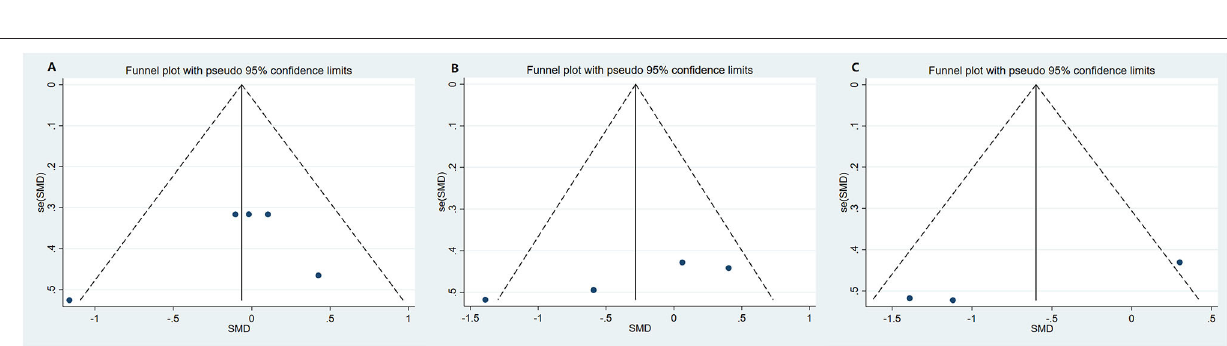
FIGURE 12 | Forest plot for the effect of microbiota-driven therapy on circulating L-carnitine level (subgroup analysis). The effect size of each trial or the overall was represented as black diamond and the weight of each trail in the overall study was represented as gray box around black diamond. The estimated 95% confidence interval of effect size was identified by extending lines. CI, confidence interval; RCT, randomized controlled trial; SMD, Standard Mean Difference.